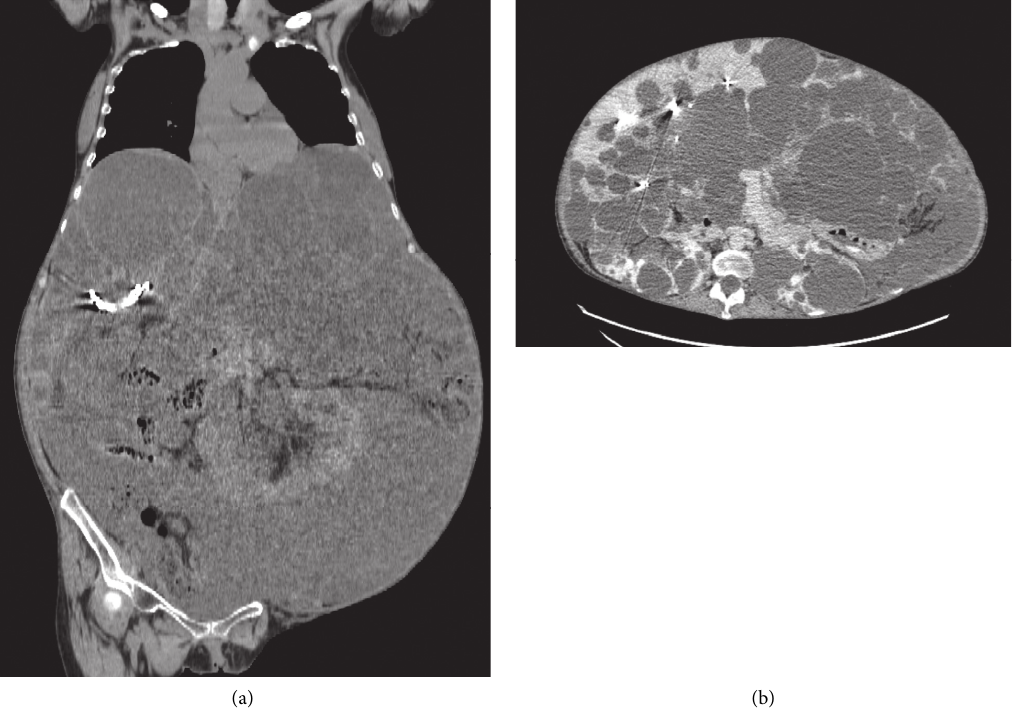
Figure 1: Preoperative images of computed tomography showing a massively enlarged polycystic liver that occupied the abdominal space and compressed the diaphragm and abdominal wall. (a) Coronal section. (b) Axial